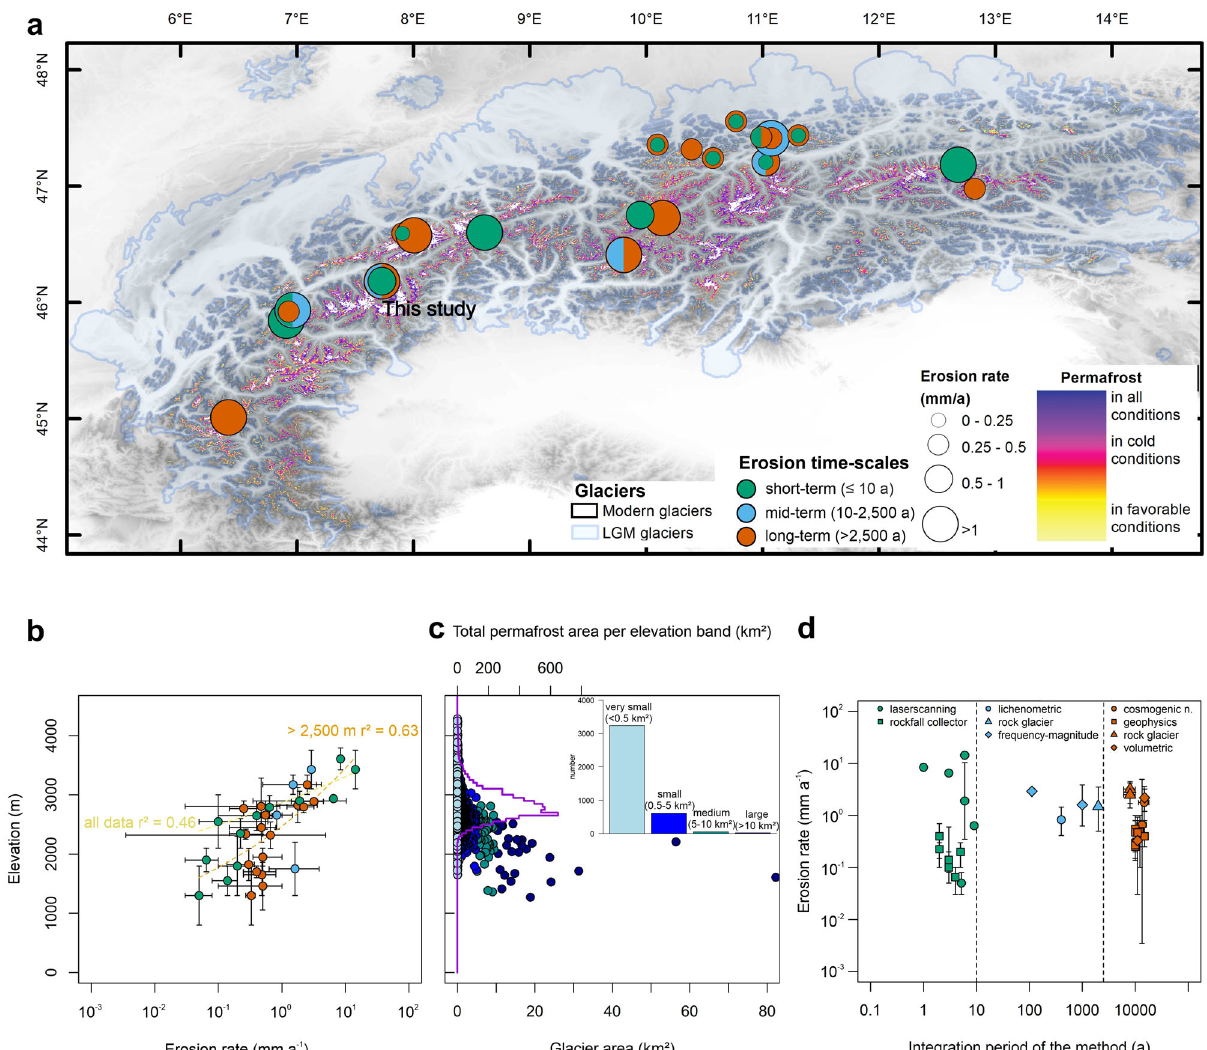
Fig. 1 Rockwall erosion rates along glacier and permafrost distribution in the European Alps. a Compiled short-term, mid-term and long-term erosion rates in the European Alps along with the extent of LGM glaciation 144 , current glaciers 36 and permafrost distribution 38,114 (DEM source: European Digital Elevation Model). b Relationship between erosion rates and elevation. The linear relationship increases from r 2 = 0.46 for all erosion rates to r 2 = 0.63 ( p < 0.001) when limited to catchment areas with mean elevation >2500m. c Inset histogram: frequency of very small glaciers (<0.5km 2 ; light blue), small glaciers (0.5 to 5km 2 , blue), medium-sized glaciers (5 to 10km 2 , turquoise) and large glaciers (>10 km 2 , dark blue) in the Alps. Main graph: Elevation of the terminus 36 of different sized glaciers (using same colours as for inset histogram) and permafrost distribution (purple line) 38,114 . d Comparison of short-, mid- and long-term erosion rates, to evaluate in fl uence of integration period (i.e. time-scale) on calculated erosion rates. Error bars indicate the minimum and maximum range of rockwall elevation and erosion rates. For detailed erosion rates including used methods, see Supplementary Table